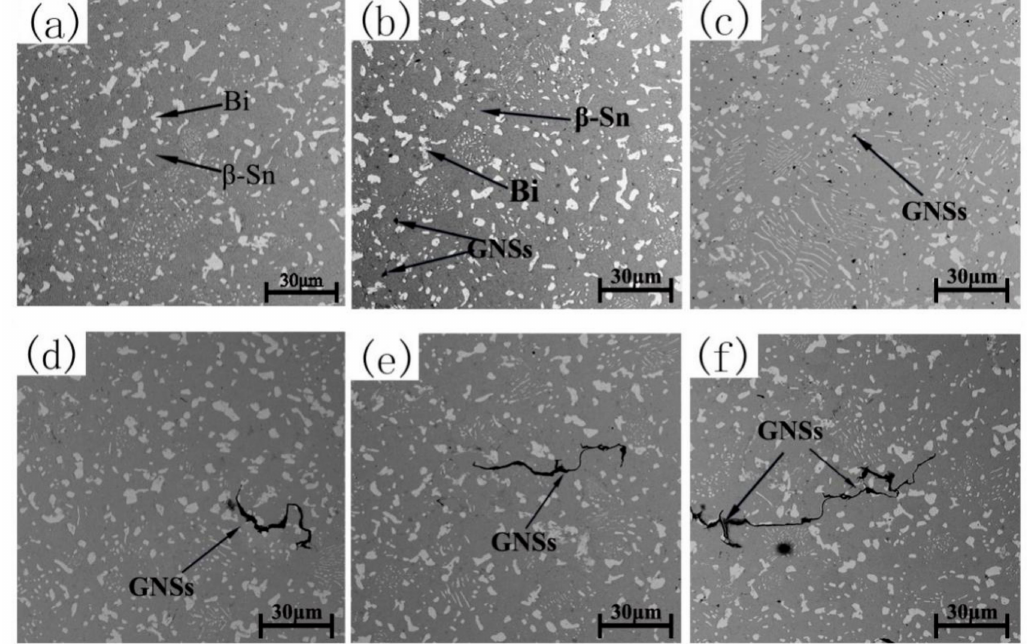
Figure 4. The SEM micrographs of Sn-20Bi-xGNSs, ( a ) x = 0, ( b ) x = 0.02, ( c ) x = 0.04, ( d ) x = 0.06, ( e ) x = 0.08, ( f ) x = 0.1.